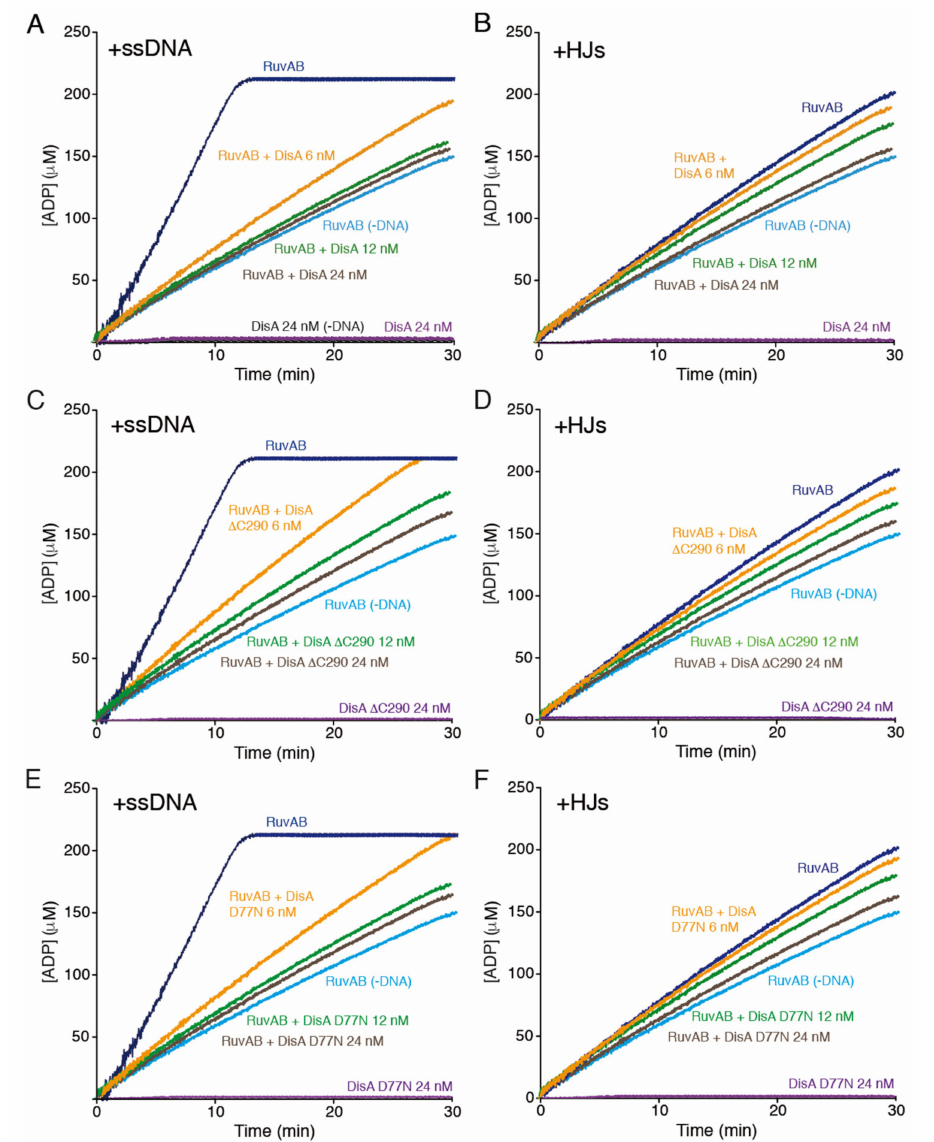
Figure 4. DisA inhibits RuvAB-mediated ATP hydrolysis. ( A , B ) The ATPase activity of the RuvAB complex (15 nM) in buffer B containing 5 mM ATP was measured during 30 min with circular 3199-nt ssDNA (in A ) or HJ DNA (in B ) as the effector. As indicated, DisA (6, 12 and 24 nM) was added, or DNA was omitted. ( C – F ) DisA inhibits RuvAB-mediated ATP hydrolysis by a direct interaction. Circular 3199-nt ssDNA (10 µ M in nt) ( C , E ) or HJ DNA ( D , F ) was incubated with RuvAB (15 nM) and DisA ∆ C290 ( C , D ) or DisA D77N ( E , F ) (6 to 24 nM) in buffer B containing 5 mM ATP, and the ATPase activity was measured (30 min at 37 ◦ C). All reactions were repeated three or more times with similar results, representative graphs are shown here, and the mean K cat ± SEM are listed in Table